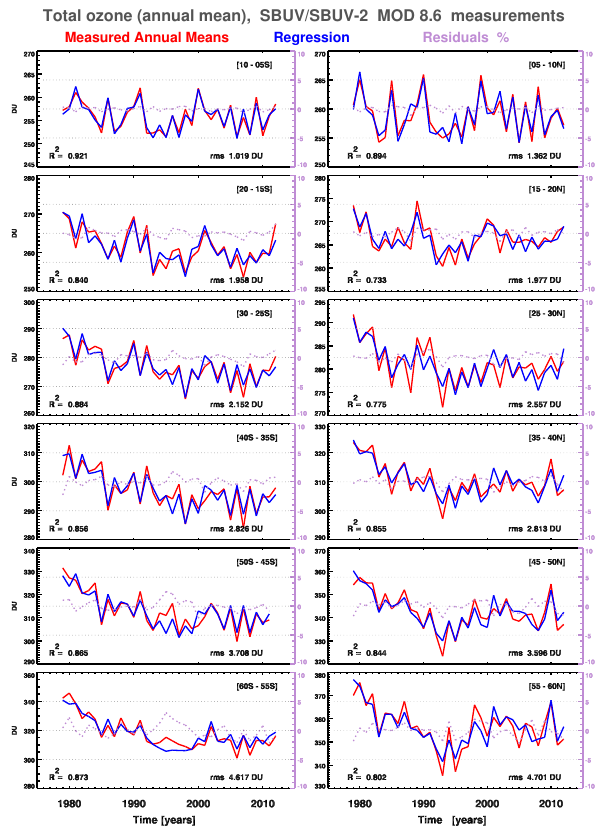
Figure 5. Observed SBUV/SBUV-2 V8.6 (red) annual zonal mean total ozone columns for selected latitude bands from 65 ◦ S to 65 ◦ N and regressed (blue) ozone obtained from regression models. The right hand scale in each panel gives the residuals in percent (violet). R 2 and rms are also noted for each latitude